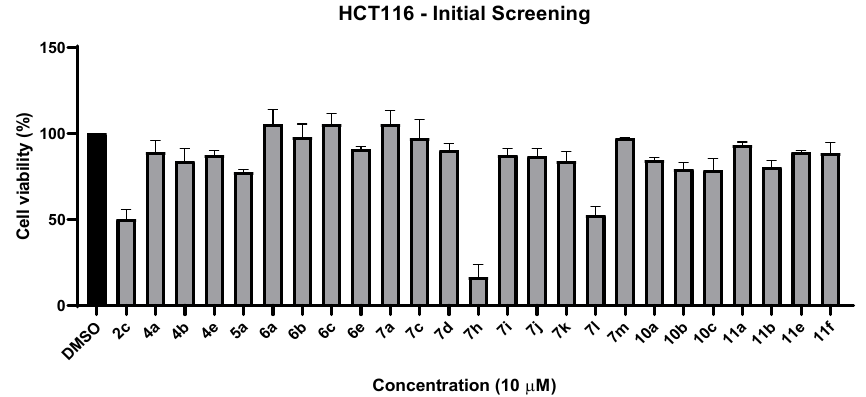
Figure 3. Initial screening results for HCT116 cells after 72 h incubation.